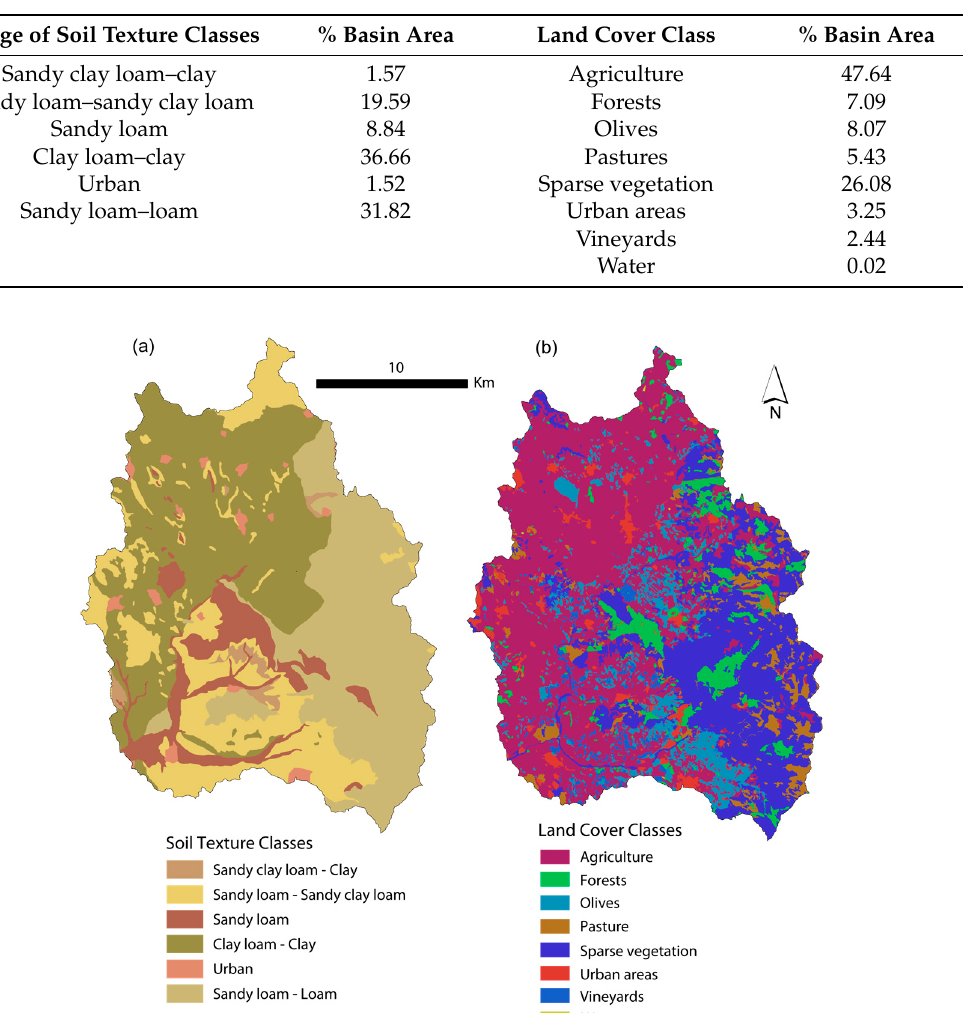
Figure 3. ( a ) Soil texture and ( b ) land cover maps used for the three hydrologic models (adapted from Perra et al.,